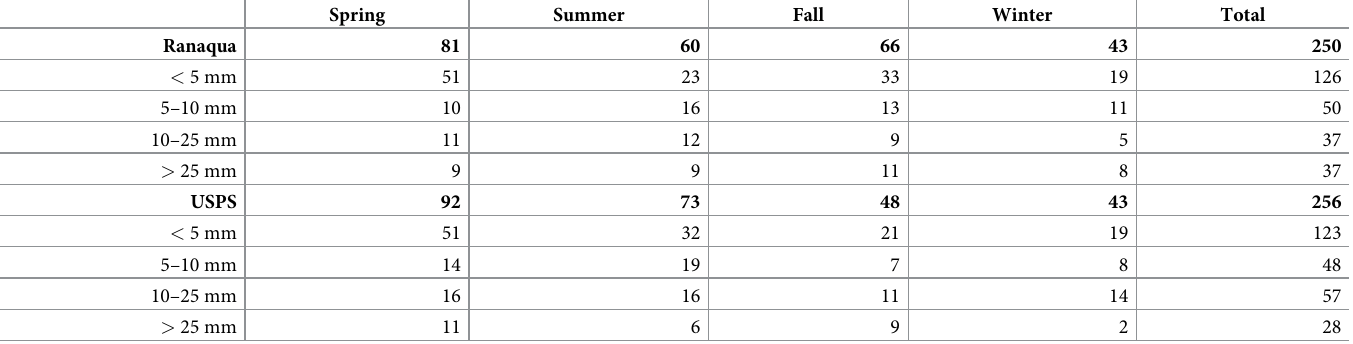
Table 1. Number of studied storm events at each green roof by size grouping and season, with seasons beginning June 21, September 21, December 21 and March 21.